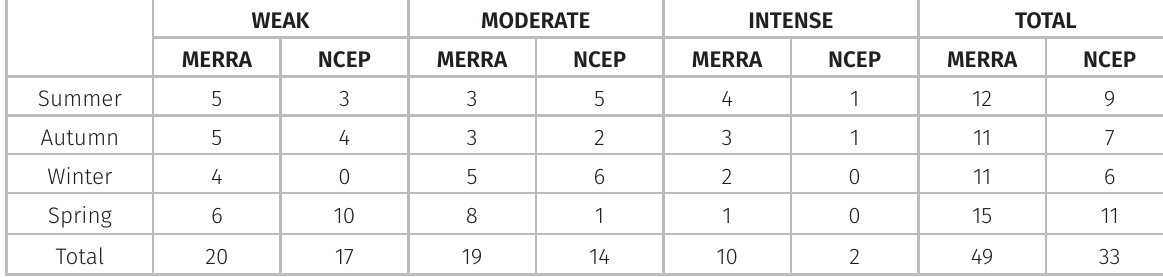
Table III. Numbers of events classified according to NDR for each season and each reanalysis, for the years 2014 and 2015.